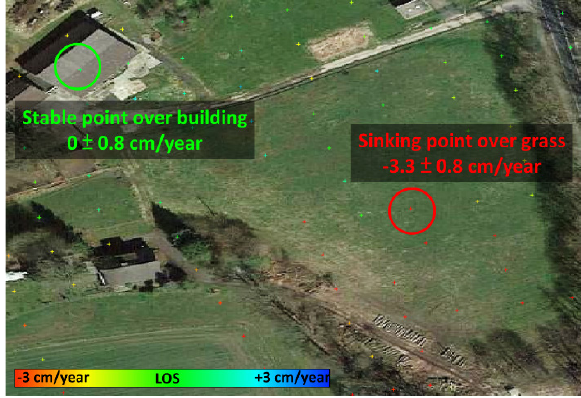
Figure 7. Examples of stable and sinking points in SBAS deformation map (Hattingen, Germany, 2015).